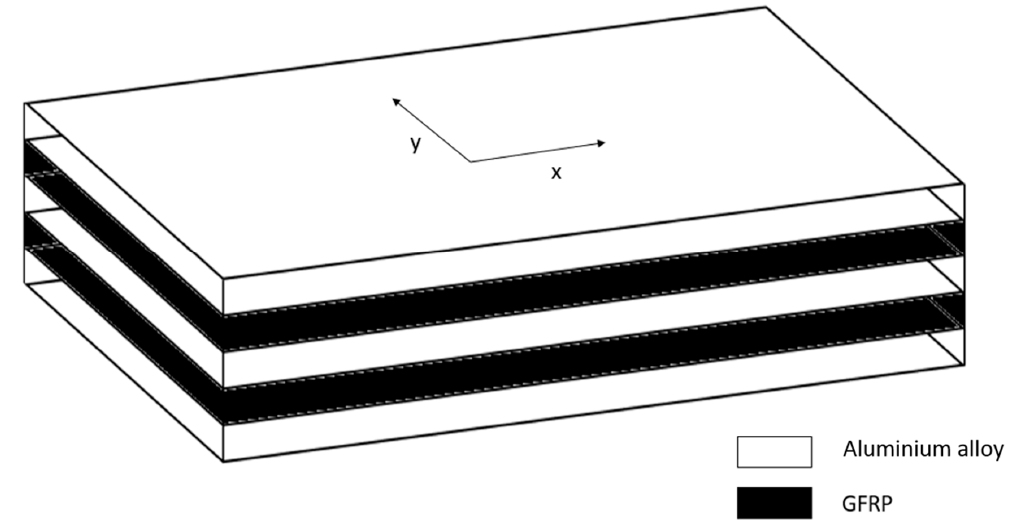
Figure 3. Scheme of the structure of specimens for which the fatigue lifetime was analyzed.